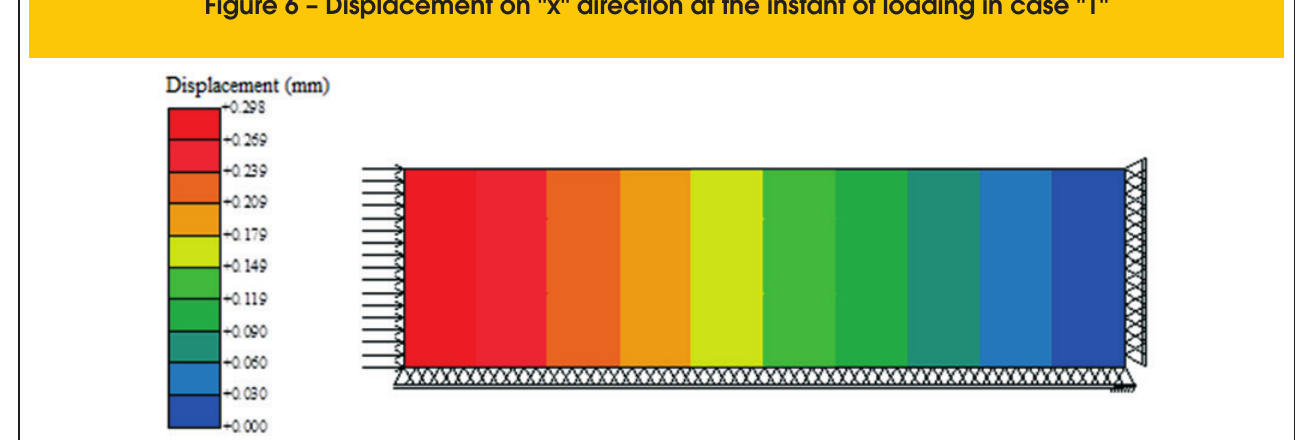
Figure 6 – Displacement on "x" direction at the instant of loading in case